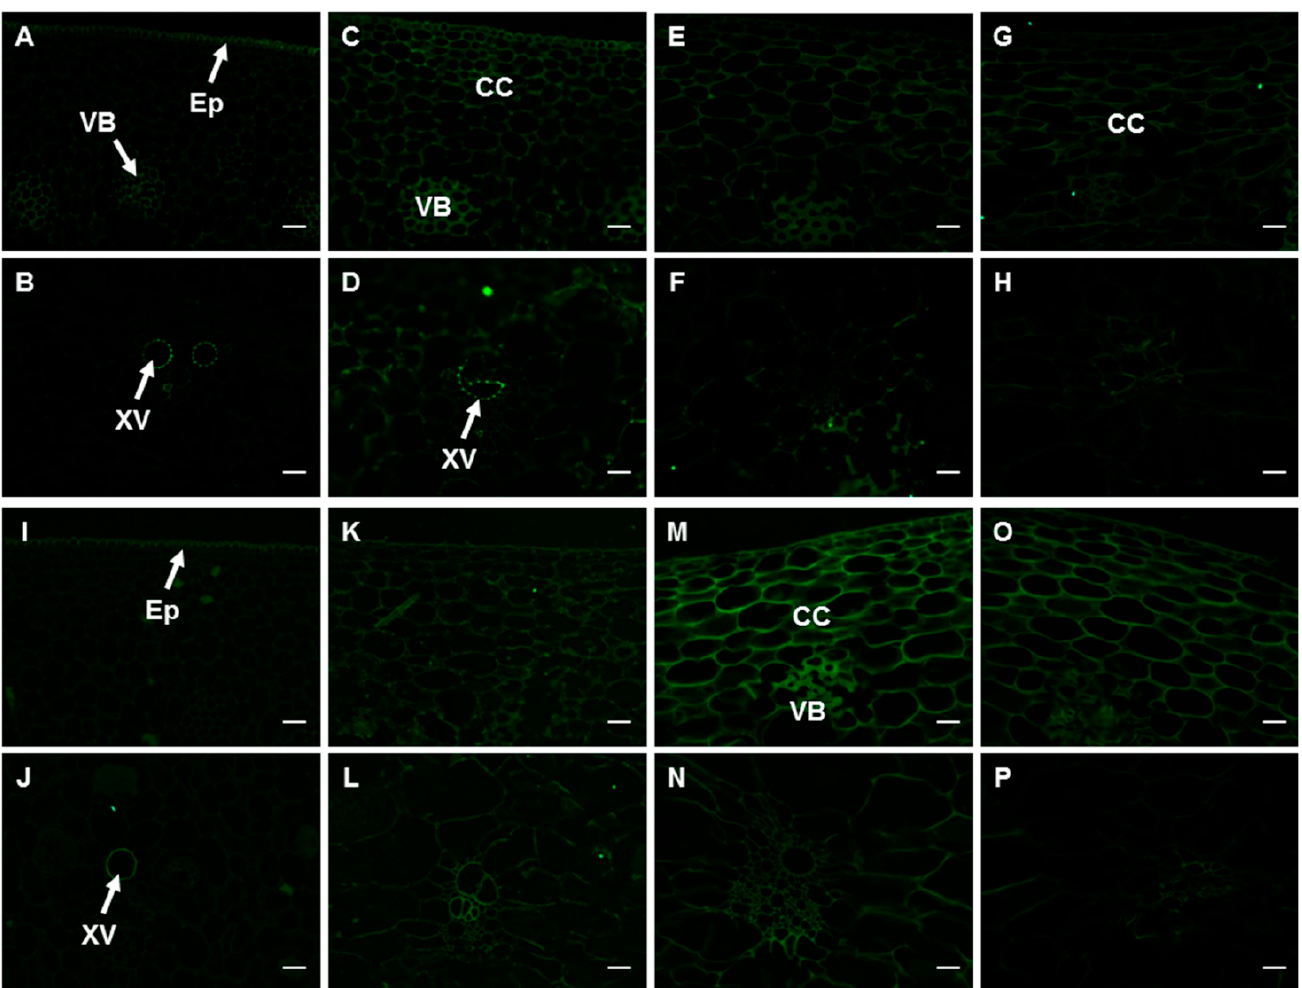
Figure 6. Spatio-temporal changes in the epitopes of JIM5 ( A – H ) and JIM7 antibodies ( I – P ) in ba- nana ( Musa spp. AAA) peel during fruit development and ripening. ( A , B , I , J ) Peel of fruits just emerging from the bunch; ( C , D , K , L ) Fruit peel at 35 d; ( E , F , M , N ) Fruit peel at harvest; ( G , H , O , P ) Fruit peel after ripening. CC: cortex cells; Ep: epidermis; XV: xylem vessel; VB: vascular bundle. Bar = 50 μ